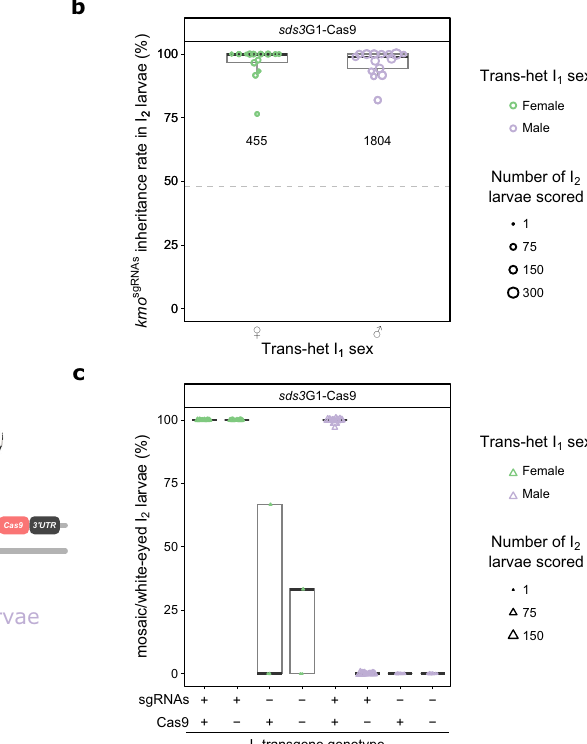
than 1.5 times the interquartile range. The size of each symbol is scaled to the amount of I 2 progeny scored. Total number of screened larvae from each cross is presented below corresponding data points. Mosquito fi gures obtained from Ramirez 38,39 . Source data are provided as a Source data fi le. pro=promoter, ♂ =male, ♀